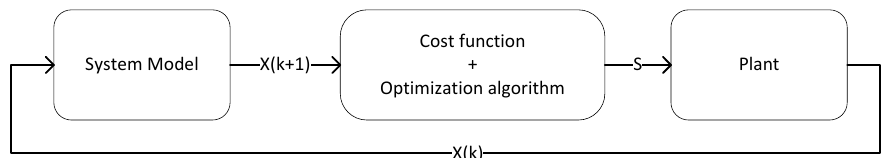
Figure 4. Finite control set model predictive control (FCS-MPC).